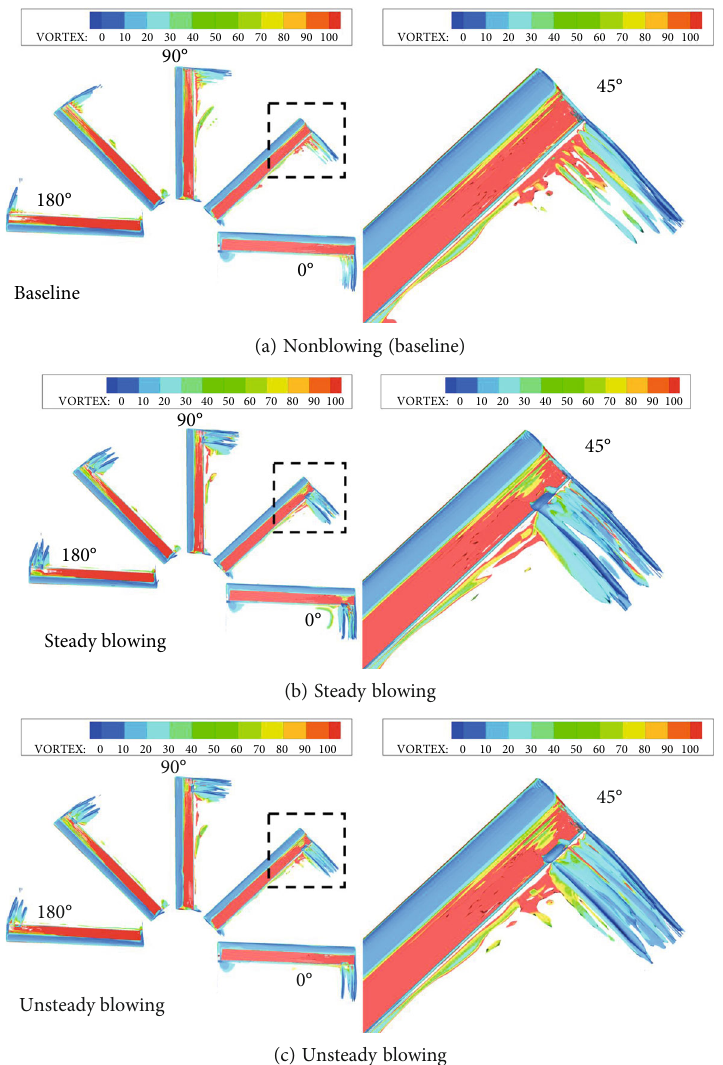
Figure 11: Near-body vortex structure from several azimuthal angles at the blade ’ s advancing side for the steady/unsteady blowing cases (isosurfaces of the Q criterion at Q = 1 , colored by vorticity magnitude).